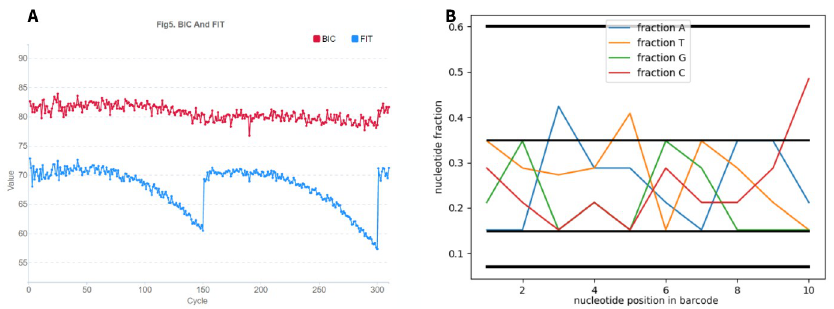
Fig 9. A–graph of the FIT and BIC distribution from the MGISEQ report for run Z10 and its NUCLEOTIDES FRACTION (B). For A: Sequencing cycles corresponding to the sequence number of the nucleotide in the reads are shown horizontally: 1:150 –forward read, 151:300 –reverse read, 301:310 –bar code sequence, vertically–FIT (blue) and BIC (red) indicators which mean the probabilities or reliability of the base call results. No drop in the FIT graph at the positions of nucleotides means that all nucleotides of barcodes can be determined by the sequencer.